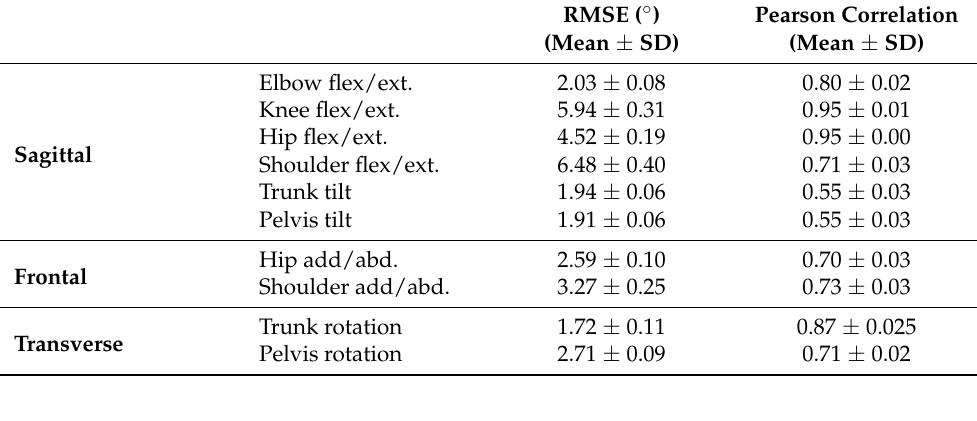
Table 2. Results of the validation of the robotic system in comparison to a Vicon system. The table shows the root-mean-square error (RMSE) and Pearson’s correlation (r) for joint kinematics. The values were averaged for all iterations.